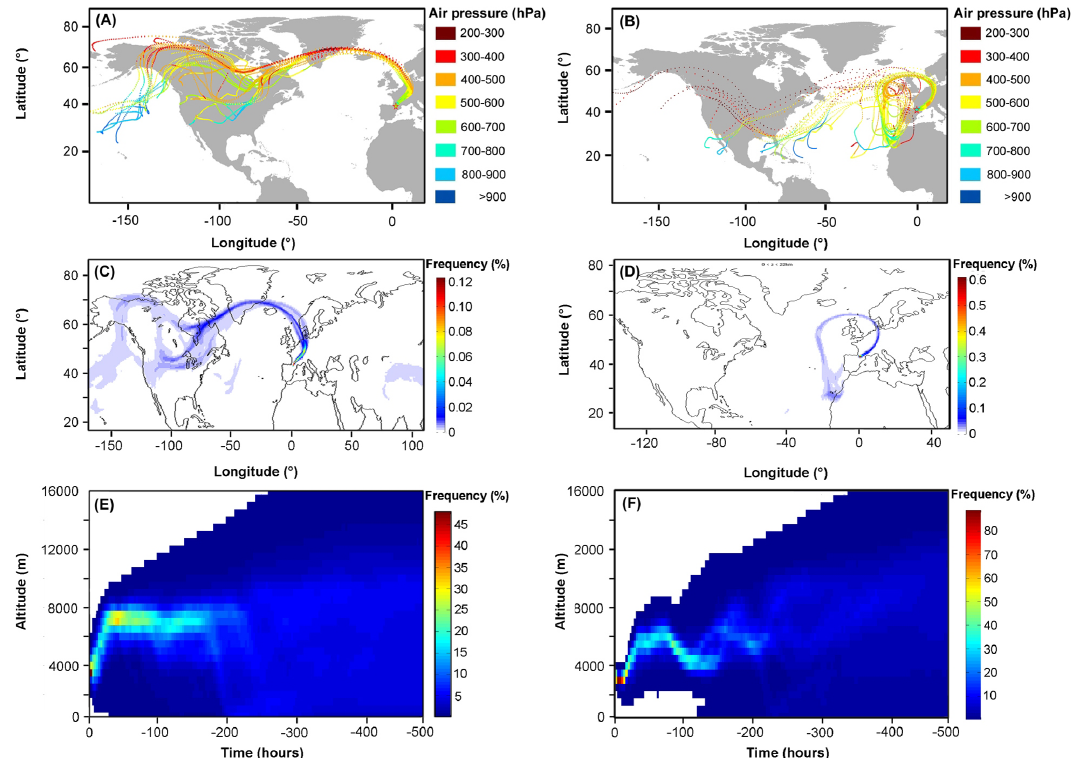
Figure 4. 240h Hysplit air mass backward trajectories for the typical high PBM events #12 (a) and #19 (b) , Flexpart simulated air mass source regions of high PBM events #12 (c) and #19 (d) and Flexpart simulated air mass traveling heights of PBM events #12 (e) and #19 (f) . To reduce the uncertainty related to Hysplit trajectory simulations (Sexauer Gustin et al., 2012), Hysplit trajectories were calculated for each of the events ended at 27 locations evenly distributed in a 0.5 ◦ × 0.5 ◦ grid cell and at a height of − 500, 0, and 500m around the PDM